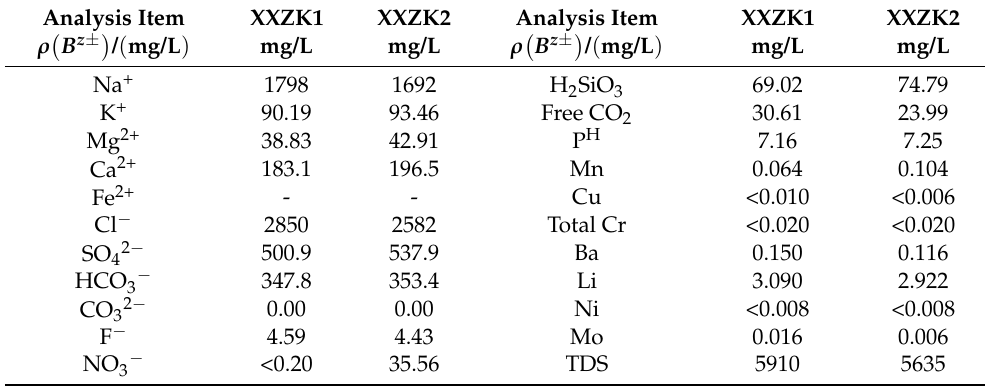
Table 2. Hydrochemical analysis of geothermal waters from wells XXZK1 and